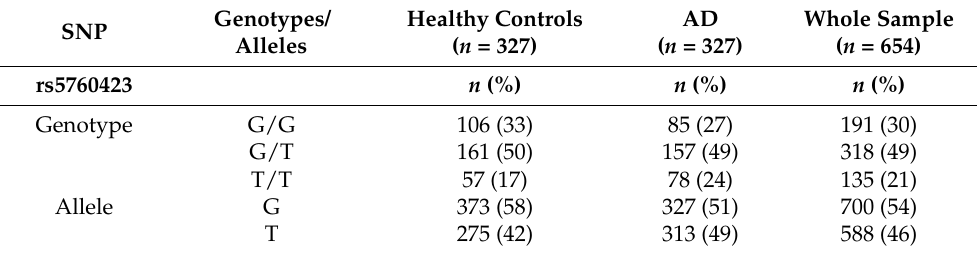
Table 1. Allelic and genotype frequencies for ADORA2A rs5760423 in healthy controls, in AD cases, and in whole sample.